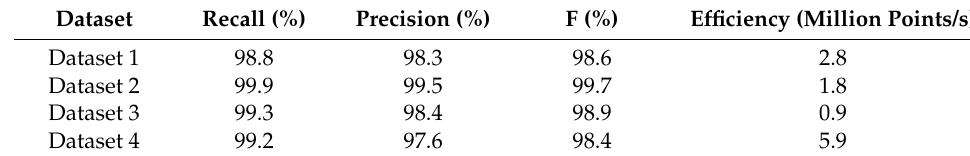
Table 5. Quantitative results of performance evaluation.